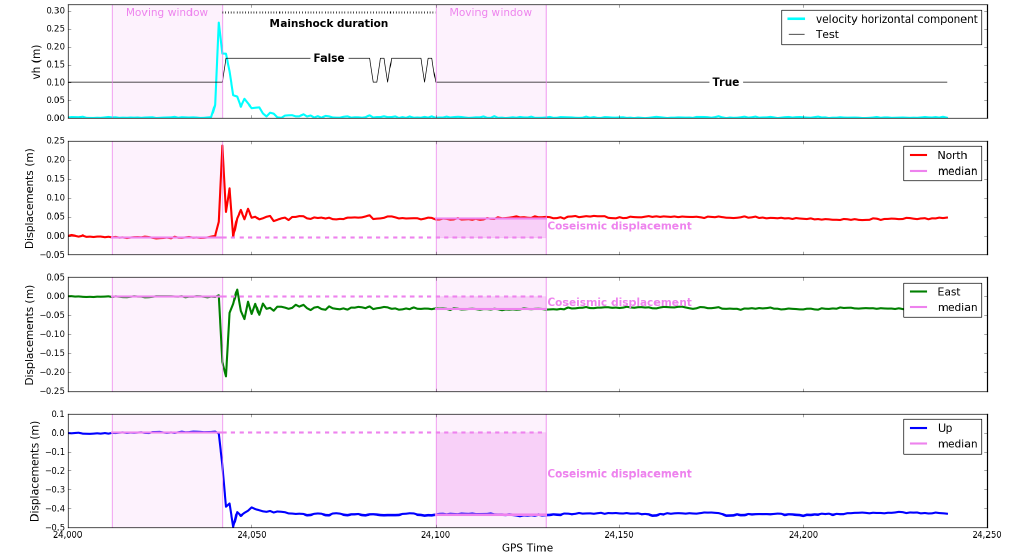
Figure 10. VADASE real-time coseismic displacement estimation at ARQT (Arquata del Tronto) for the 30 October 2016 main